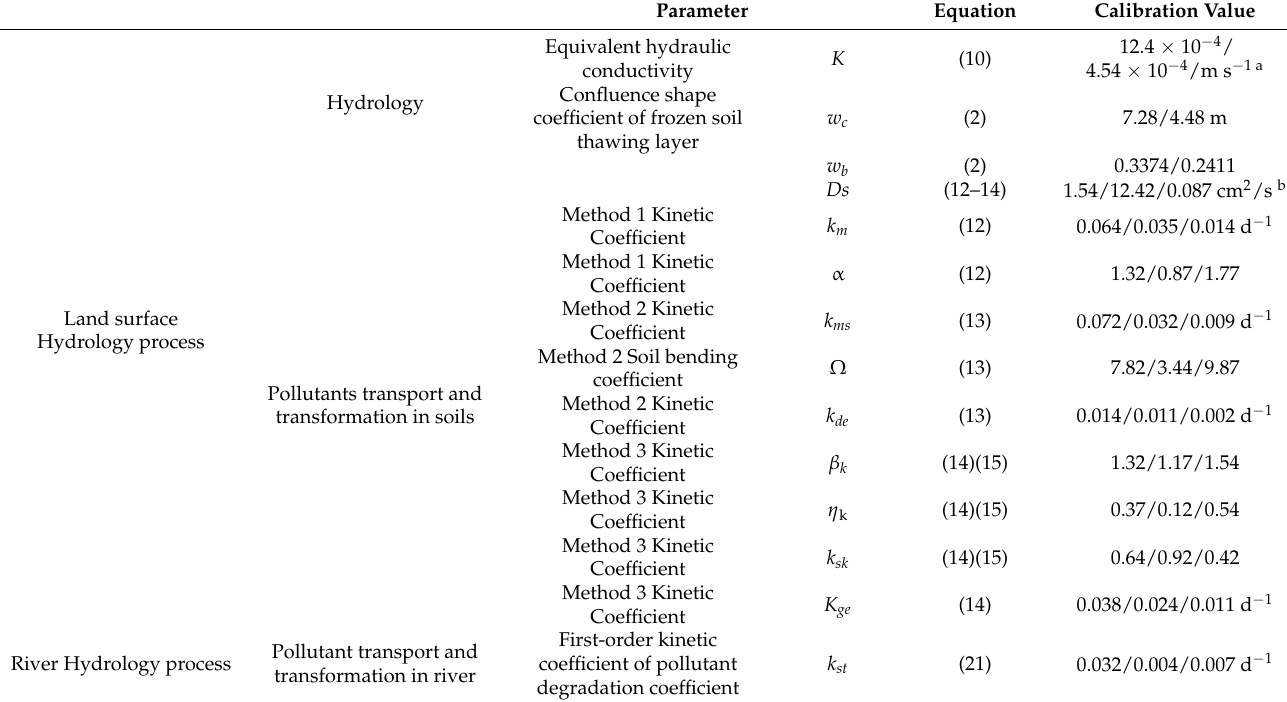
Table 2. Calibrated parameters.